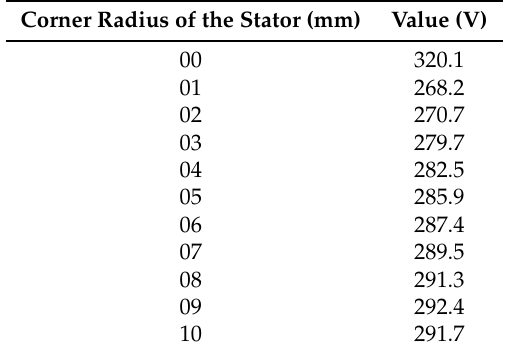
Table 2. Electrical voltage in corner of the